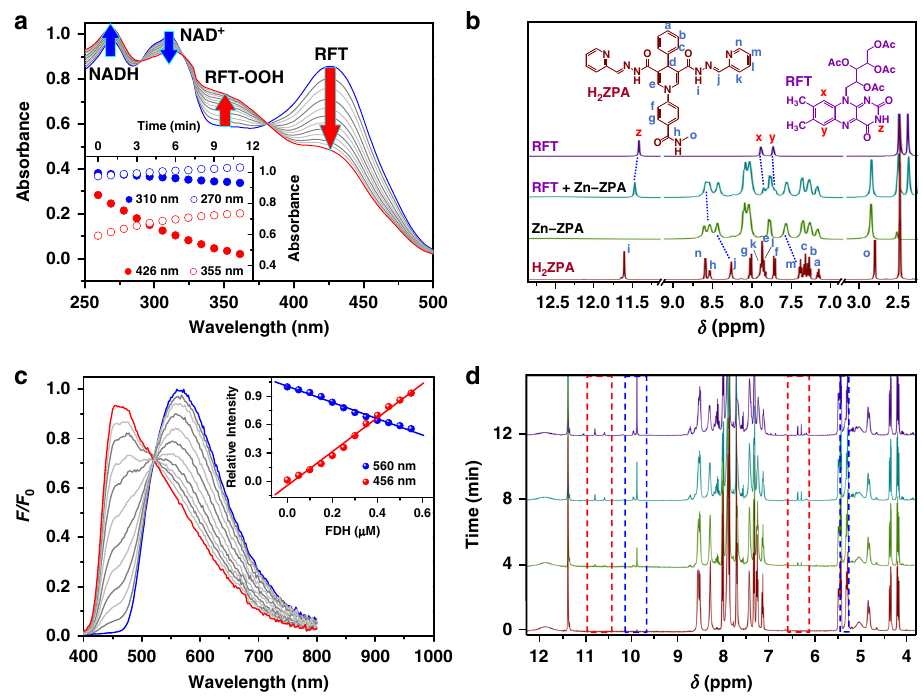
Fig. 3 Characterization of the interactions between Zn – ZPA and RFT or FDH. a UV-Vis spectrum of Zn – ZPA (10.0 μ M) and RFT (10.0 μ M) in a CH 3 CN solution in the presence of oxygen under the irradiation at 455 nm. The inset shows the changes in the absorption at 270, 310, 355 and 426 nm as a function of irradiation time. b Partial 1 H NMR spectra of the free ligand H 2 ZPA (red), Zn – ZPA (green), an equimolar mixture of Zn – ZPA and RFT (cyan) and RFT (purple) in DMSO- d 6 . c Family of luminescence spectra of Zn – ZPA (10.0 μ M) in CH 3 CN/H 2 O (2:1) upon the addition of FDH (total 0.5 μ M). The inset shows the changes at 460 and 565 nm. d Partial 1 H NMR spectra recorded during the reaction of an equimolar Zn – ZPA and RFT in the absence of oxygen under the irradiation at 455 nm in DMSO- d 6